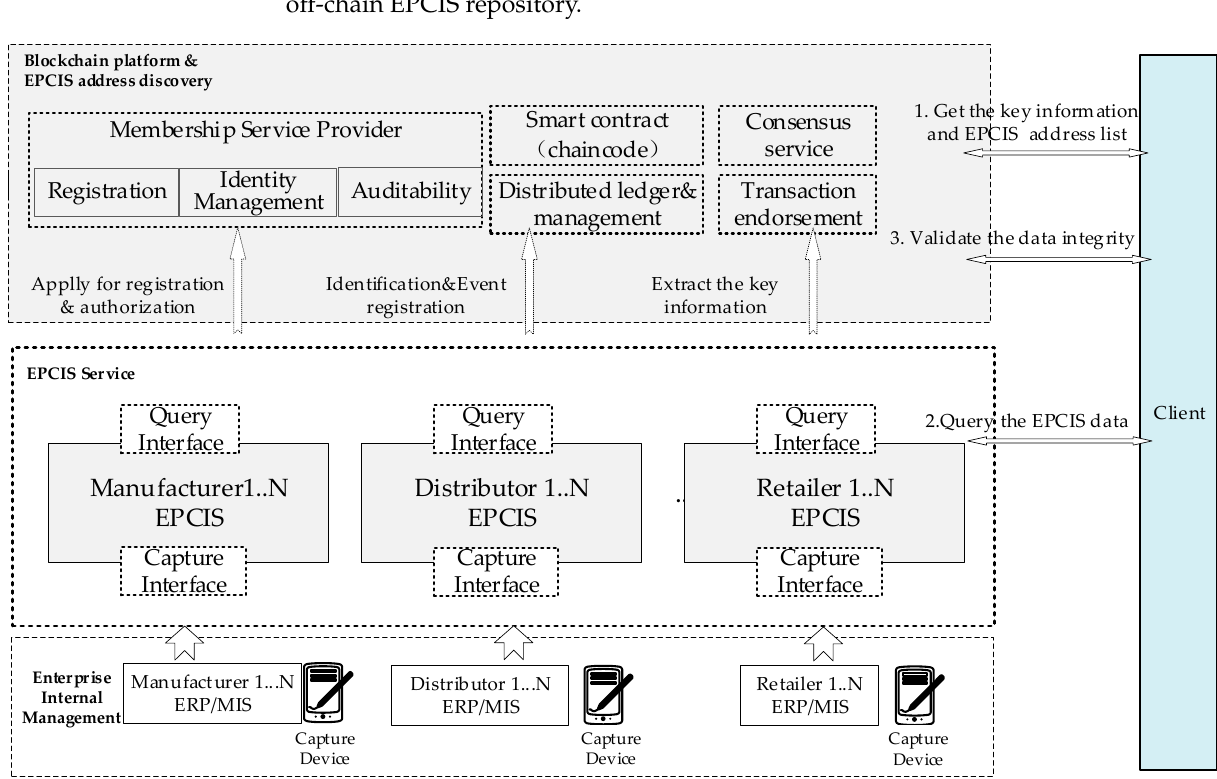
Figure 3. Trustworthy data service model based on the IoT and blockchain.